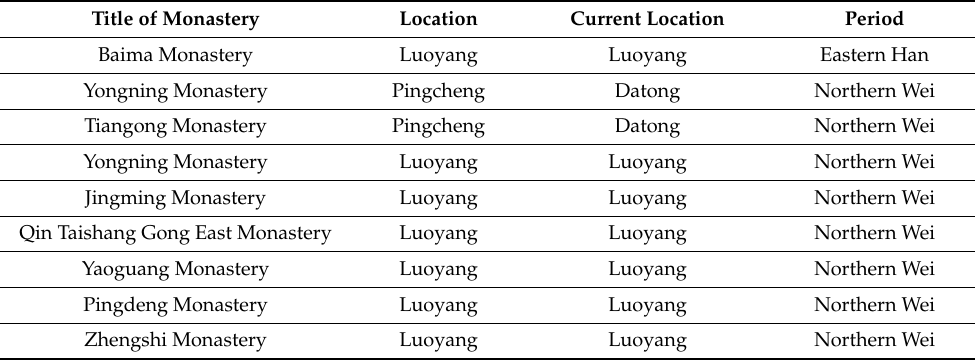
Table A1. List of Buddhist monasteries to be